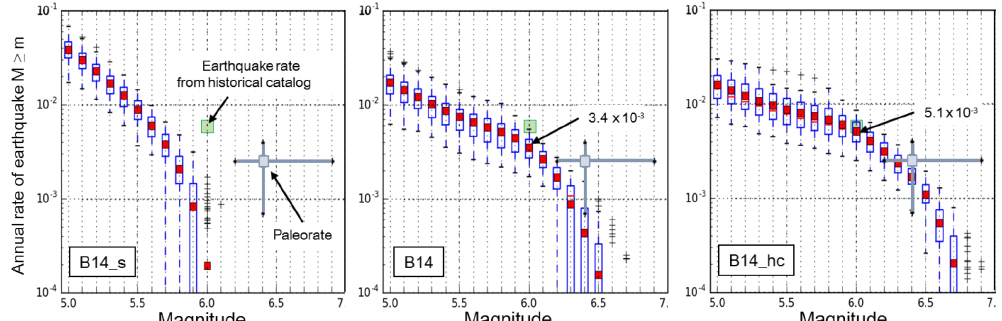
Figure 6. Rate of earthquakes occurring on the Aigion fault for each FtF rupture set. Variability resulting from the exploration of the logic tree is illustrated by the blue boxes. The annual rates of M w ≥ 6 earthquakes on Aigion fault are indicated for the B14 and B14_hc models. The grey square represents the paleorate (rate of paleoearthquakes) interpreted from Pantosti et al. (2004) with its uncertainties. The green box represents the rate of earthquakes greater than M w 6 on the Aigion fault inferred from the historical catalog.